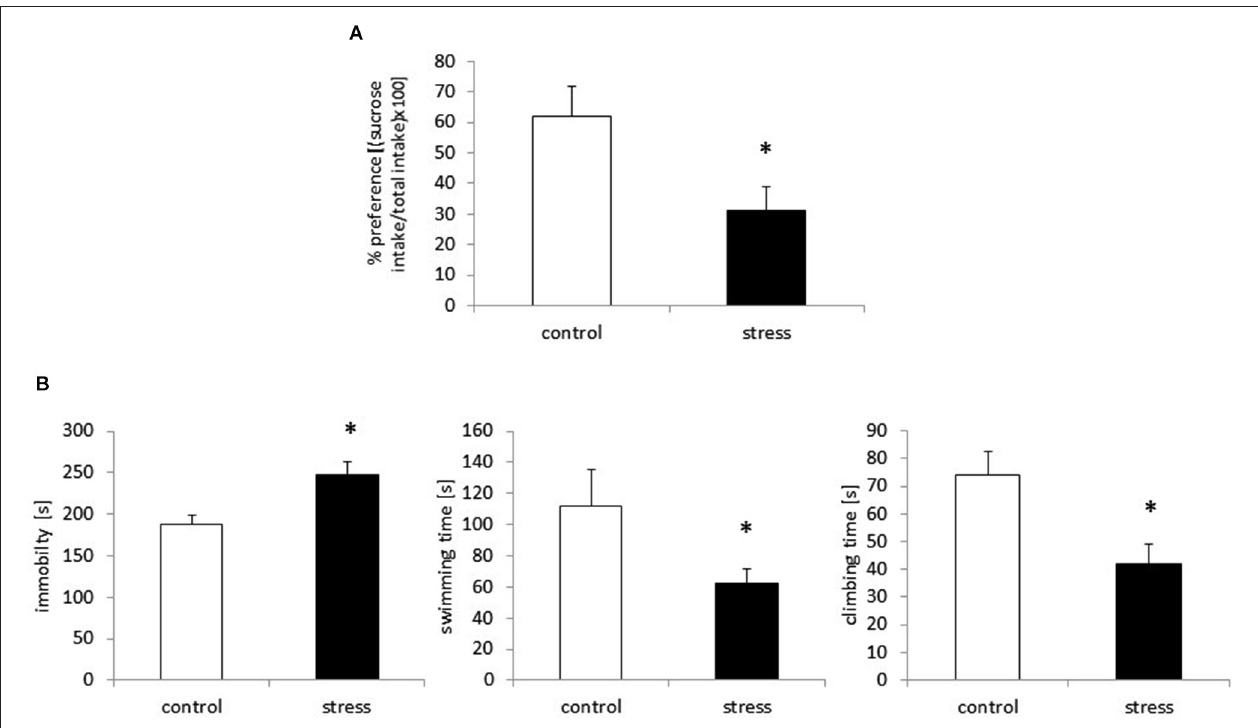
leads to depressive-like behavior: increased immobility and decreased swimming and climbing time in Forced swimming test (B) , the results are expressed in [s] ± SD; n = 10 in each group; * p < 0.05; one-way